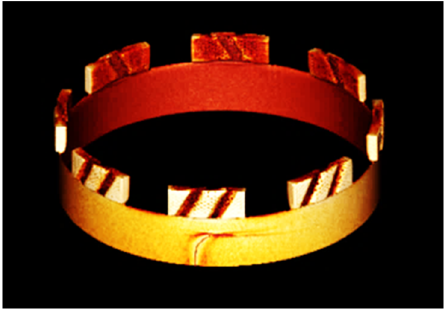
Figure 7. Recording of the drill bit.